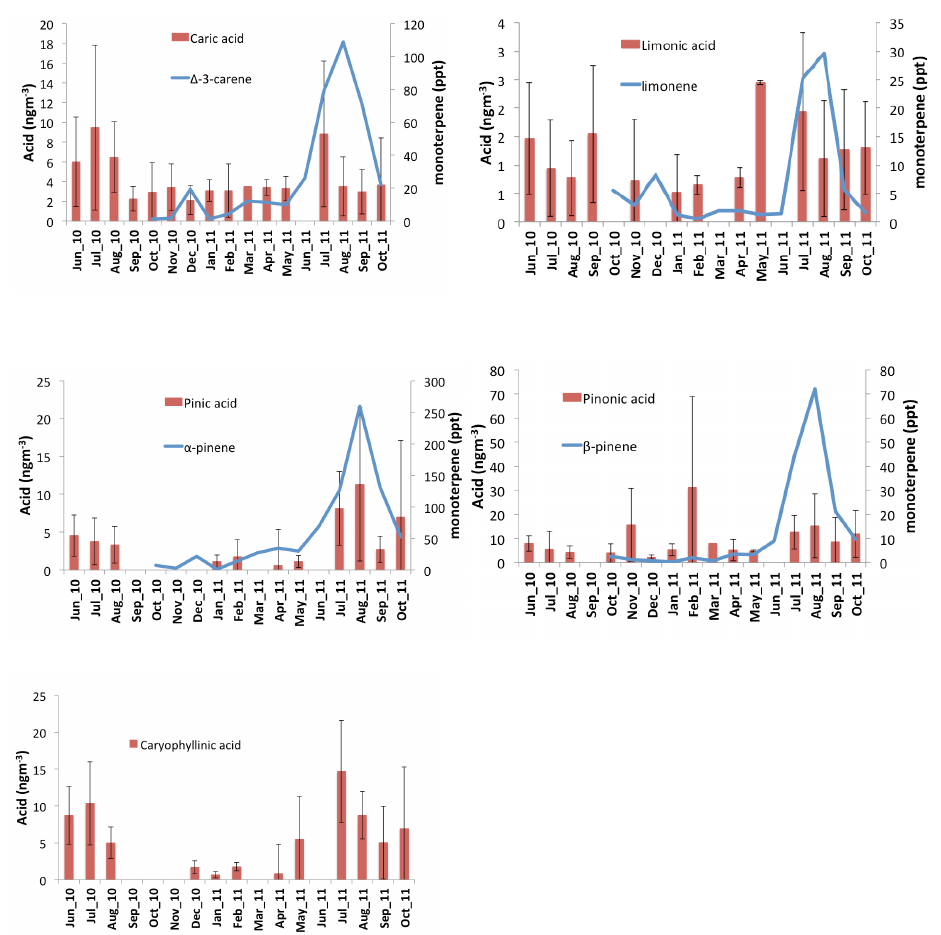
Figure 2. Monthly mean terpenoic acid concentrations and their standard deviations together with monthly mean monoterpene concentrations from Hakola et al.